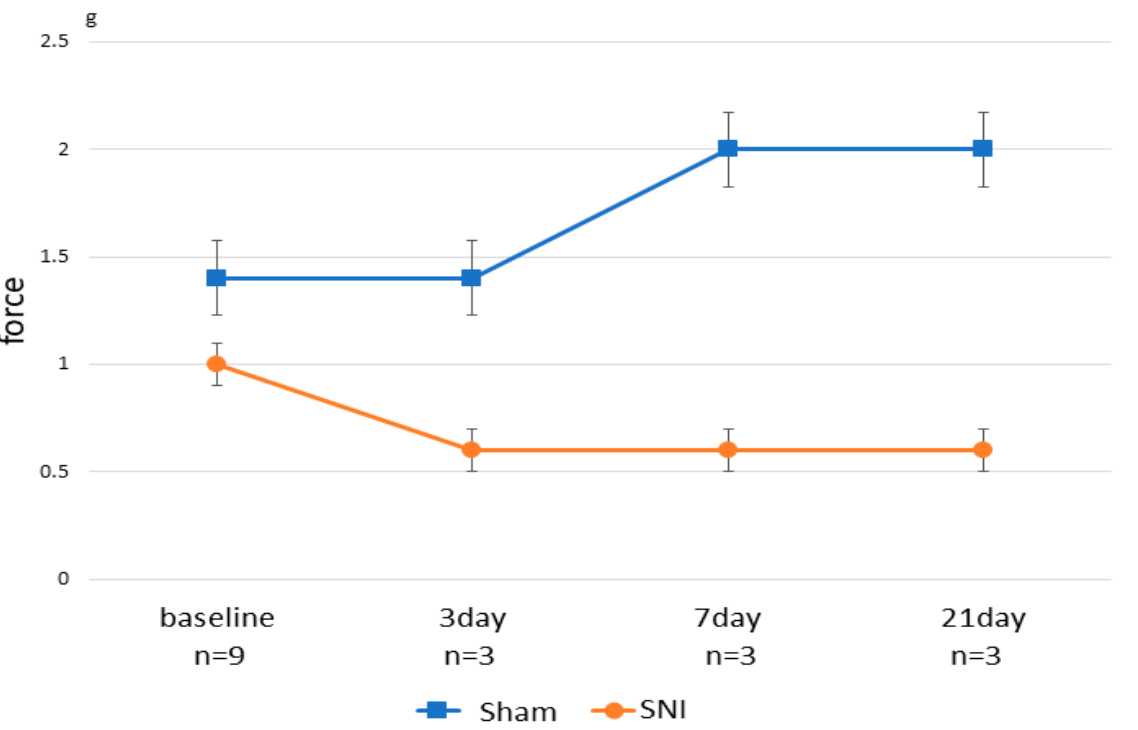
Figure 1. Time series results of the von Frey behavior test. The vertical axis represents the minimum force (g) at which mice responded positively in behavioral tests. The baseline is the value of behavioral tests before SNI or Sham treatment. Behavioral tests on Days 3, 7, and 21 were performed before the sacrifice, respectively.